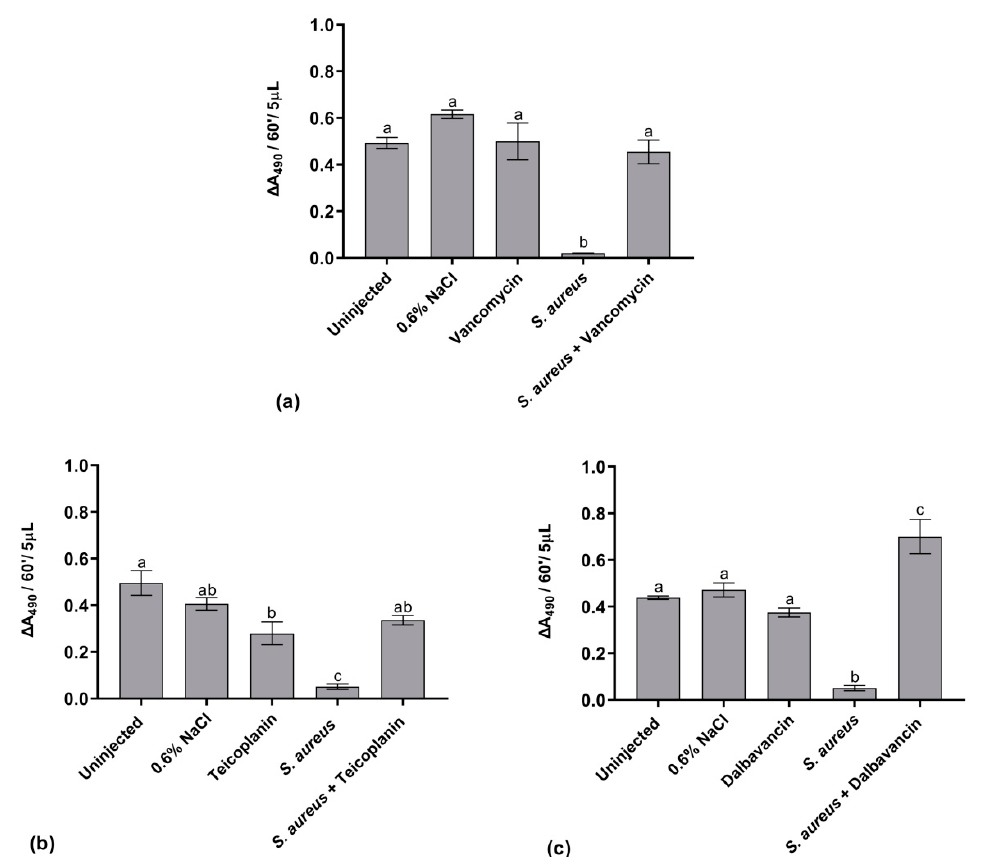
Figure 7. Analysis of phenoloxidase (PO) activity in control larvae (uninjected larvae and larvae injected only with physiological solution) and in healthy and infected larvae treated and untreated with vancomycin ( a ), teicoplanin ( b ), and dalbavancin ( c ) at 8.75 μ g/g body weight. Values represent mean ± s.e.m. Different letters indicate statistically significant differences among treatments ( p < 0.05).